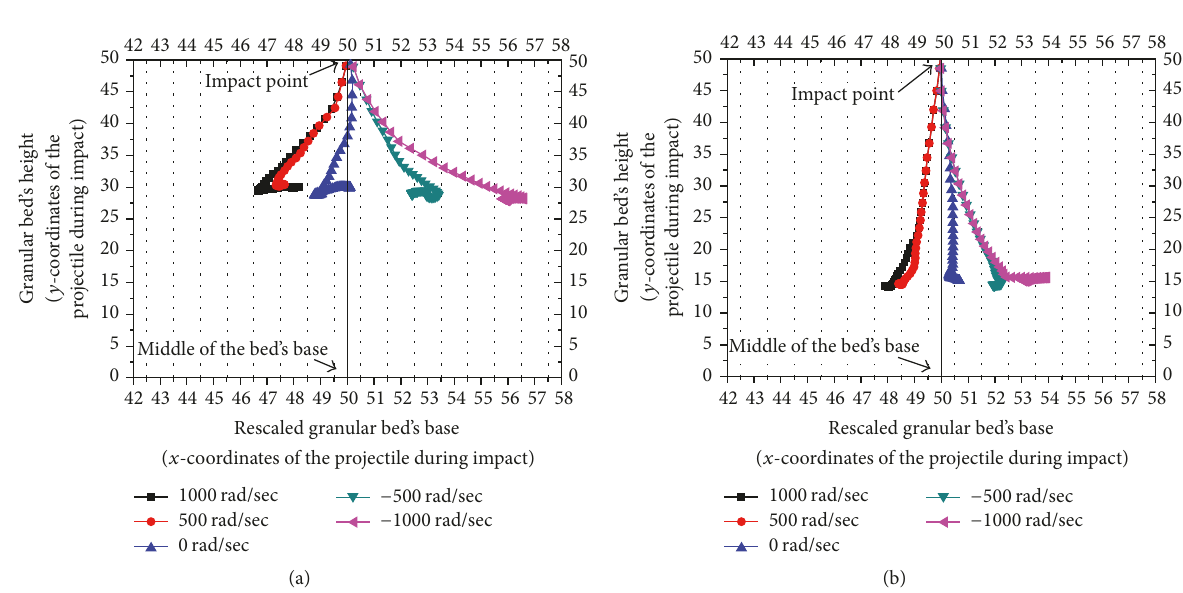
Figure 2: Deviation of the projectile’s 𝑥 -coordinate ultimate stopping point from that of its original impact point for various values of angular velocities. (a) Multisized particle bed. (b) Monosized particle bed.